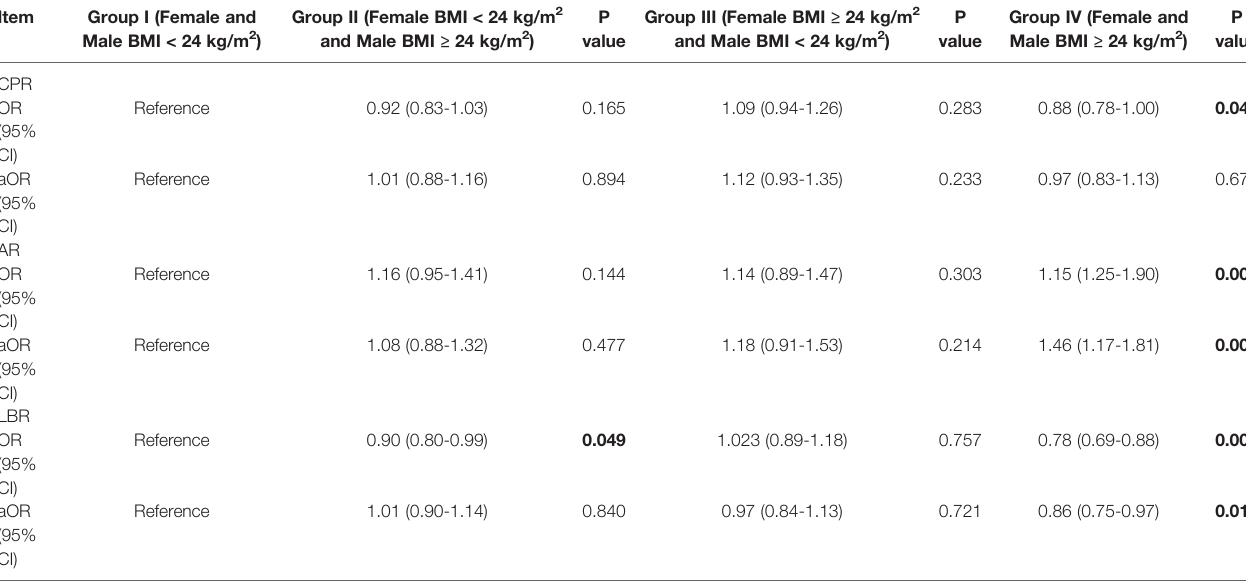
TABLE 4A | Logistic regression analysis on the effect of female and male BMI on pregnancy outcomes in IVF cycles. Item Group I (Female and Male BMI < 24 kg/m 2